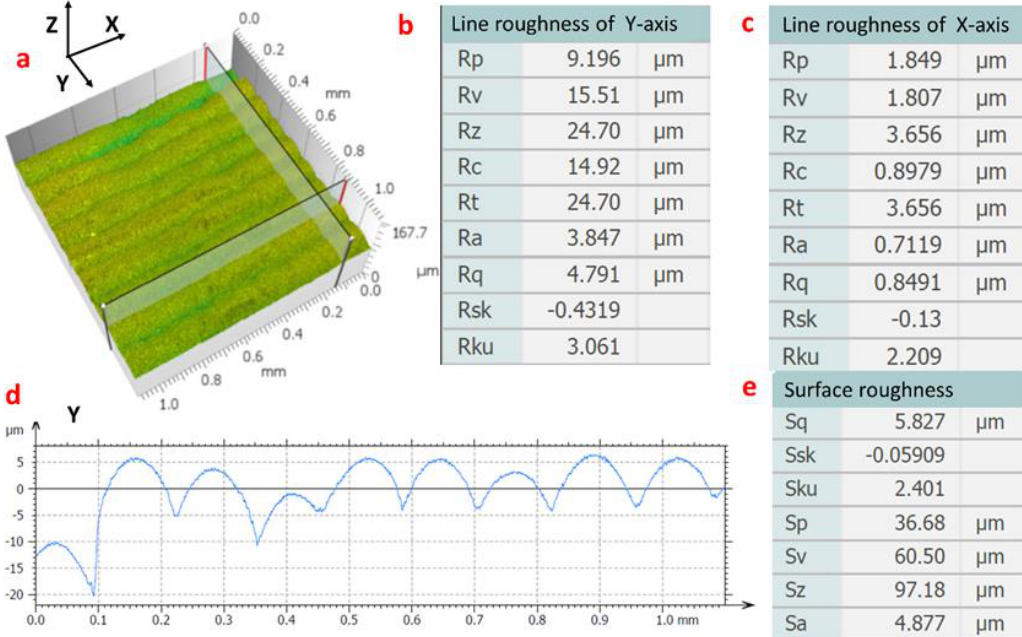
Table 5. Comparison of the proposed LJWF-DMD process with some research works from the liter- ature.